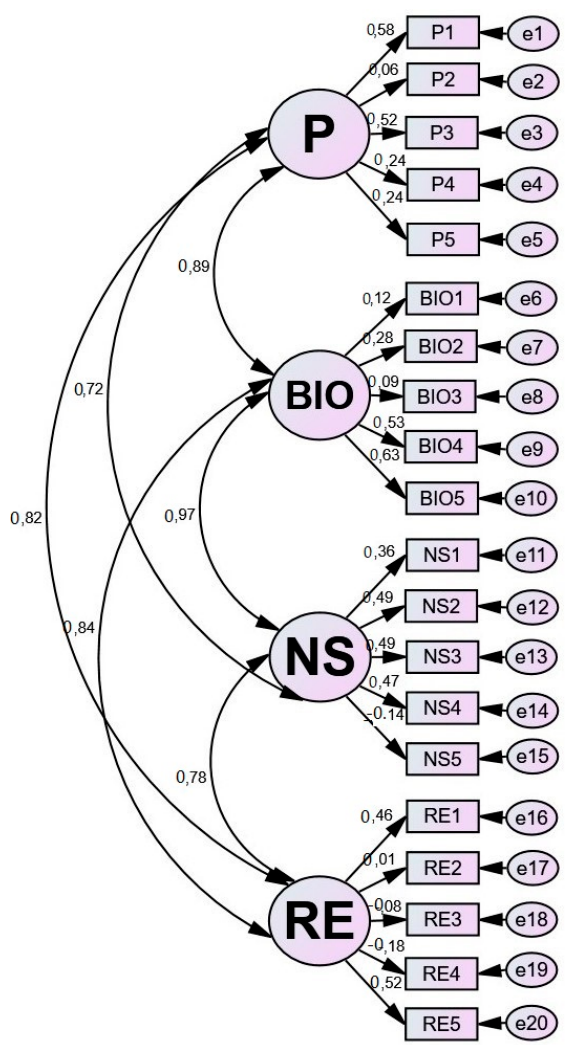
Figure 2. Estimations of the structural equation model. Note: Chi-square = 323,834; df = 164; p -value = 0.000; P = Pollution; BIO = Biodiversity; NS = Natural Spaces; RE = Recycling.